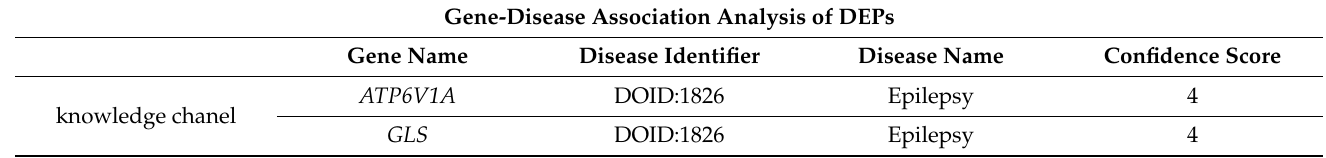
Table 6. Epilepsy related genes with a confidence score > 2 in the Disease 2.0